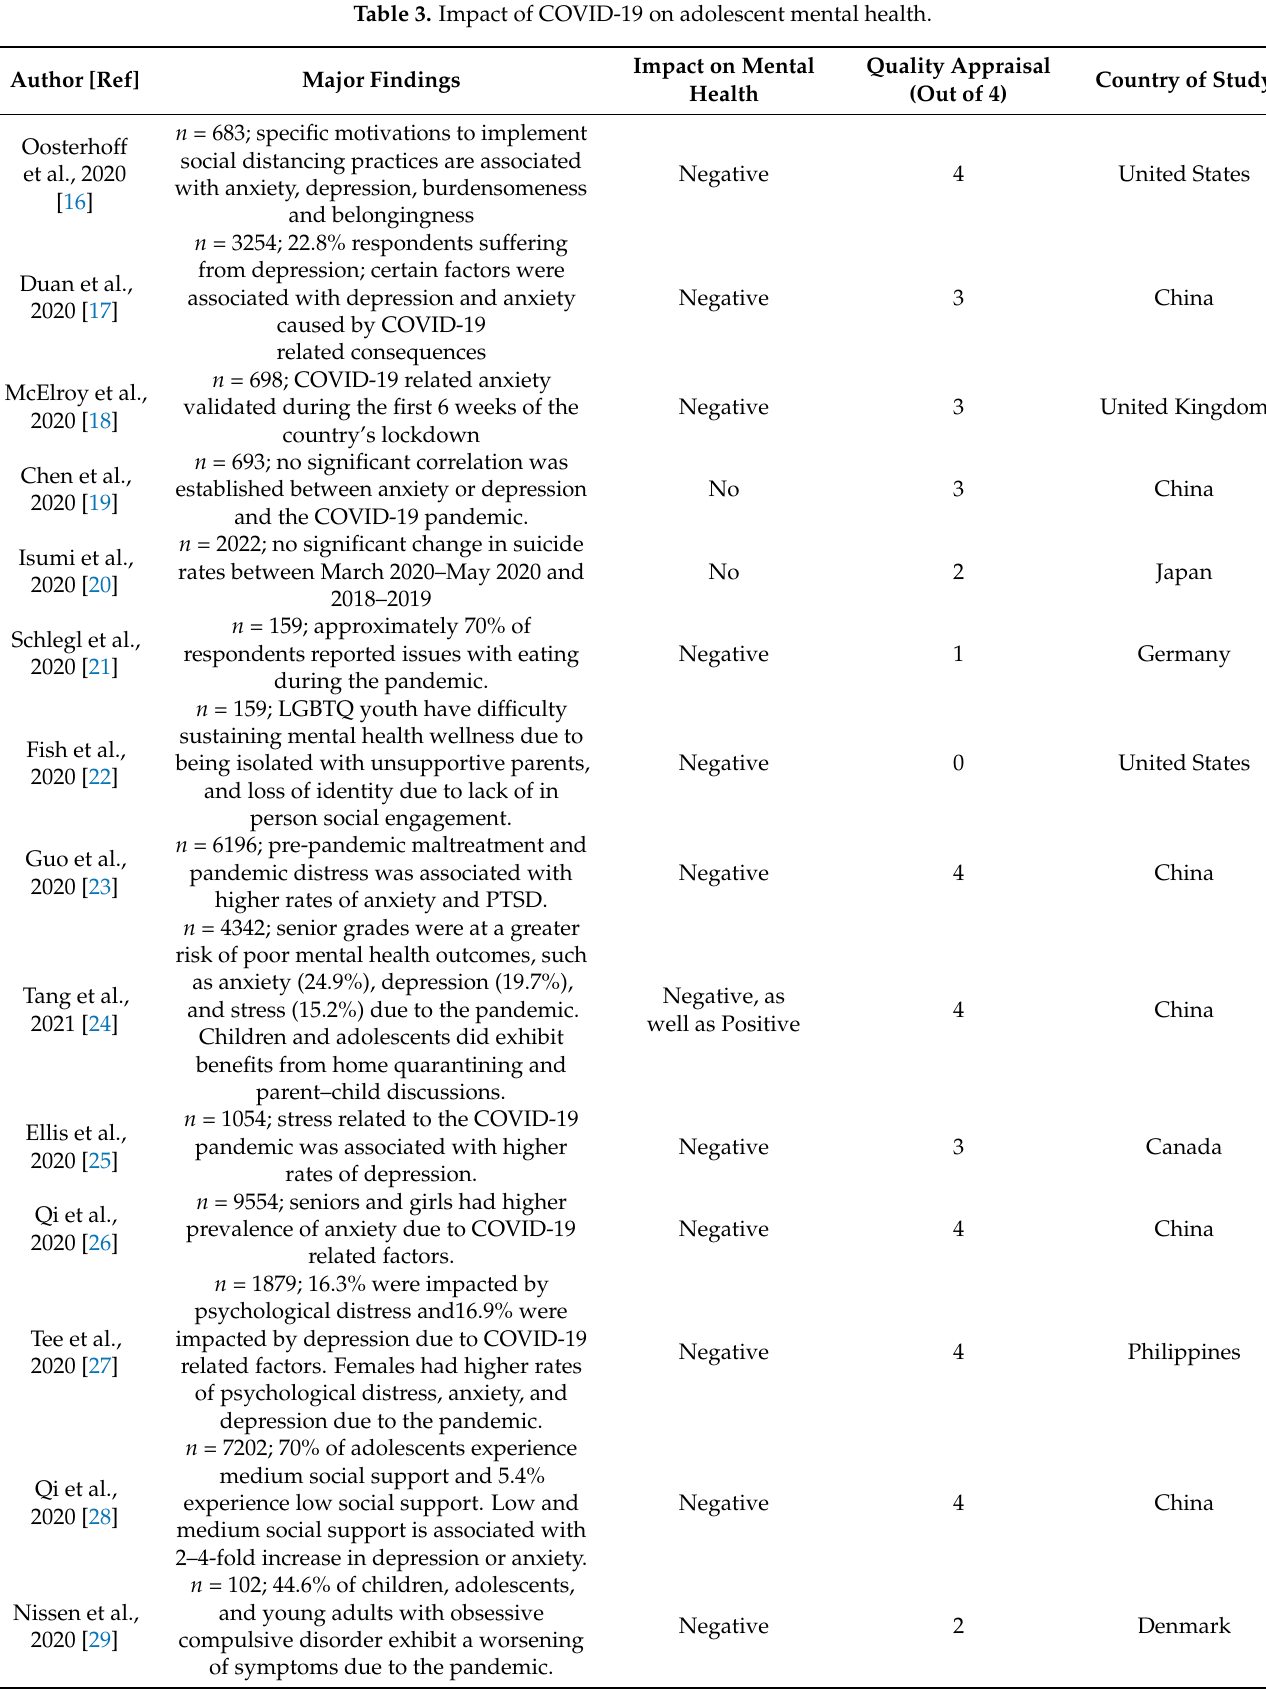
Table 3. Impact of COVID-19 on adolescent mental